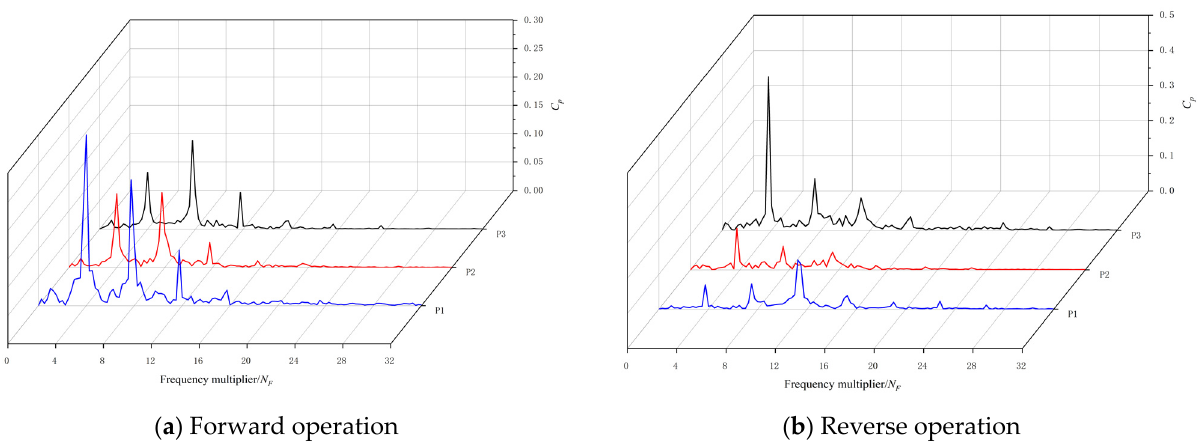
Figure 12. Pressure pulsation distribution of bidirectional axial flow pump in optimal condition of 1.00 Q bep . 1.00 Q bep